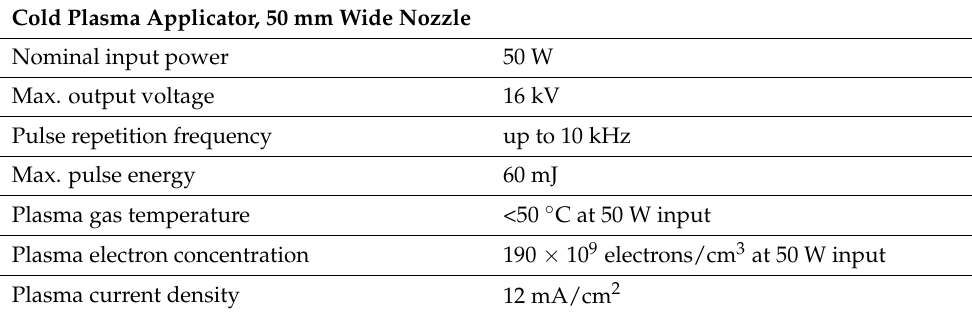
Table 1. The obtained measured and computed parameters.